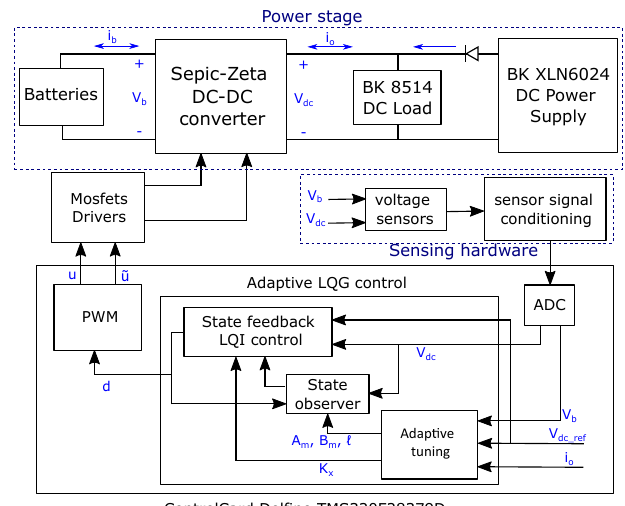
Figure 20. Test bench scheme of the battery charger/discharger.